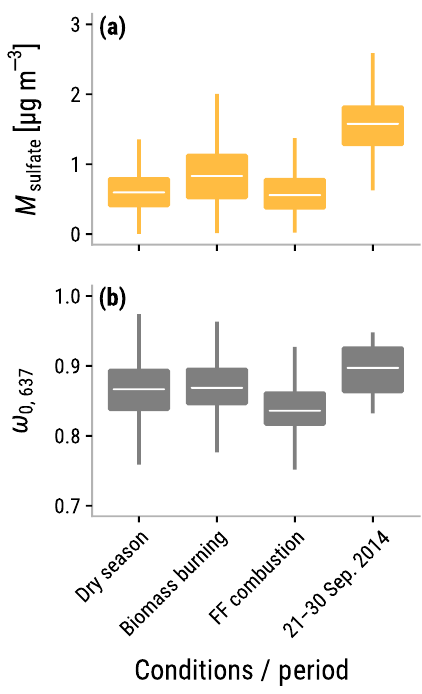
Figure 2. Box and whisker plots of hourly mean (a) sulfate mass concentration, M sulfate , and (b) single scattering albedo at 637nm, ω 0 , 637 , during different periods and conditions including the dry season average 2014–2016, biomass burning and fossil fuel combustion-influenced conditions, and the period of interest from 21 to 30 September 2014. The white segment inside the box repre- sents the median. The lower and upper box edges represent the first and the third quartiles, respectively. The whiskers represent the low- est and highest observations within the 99.3% confidence